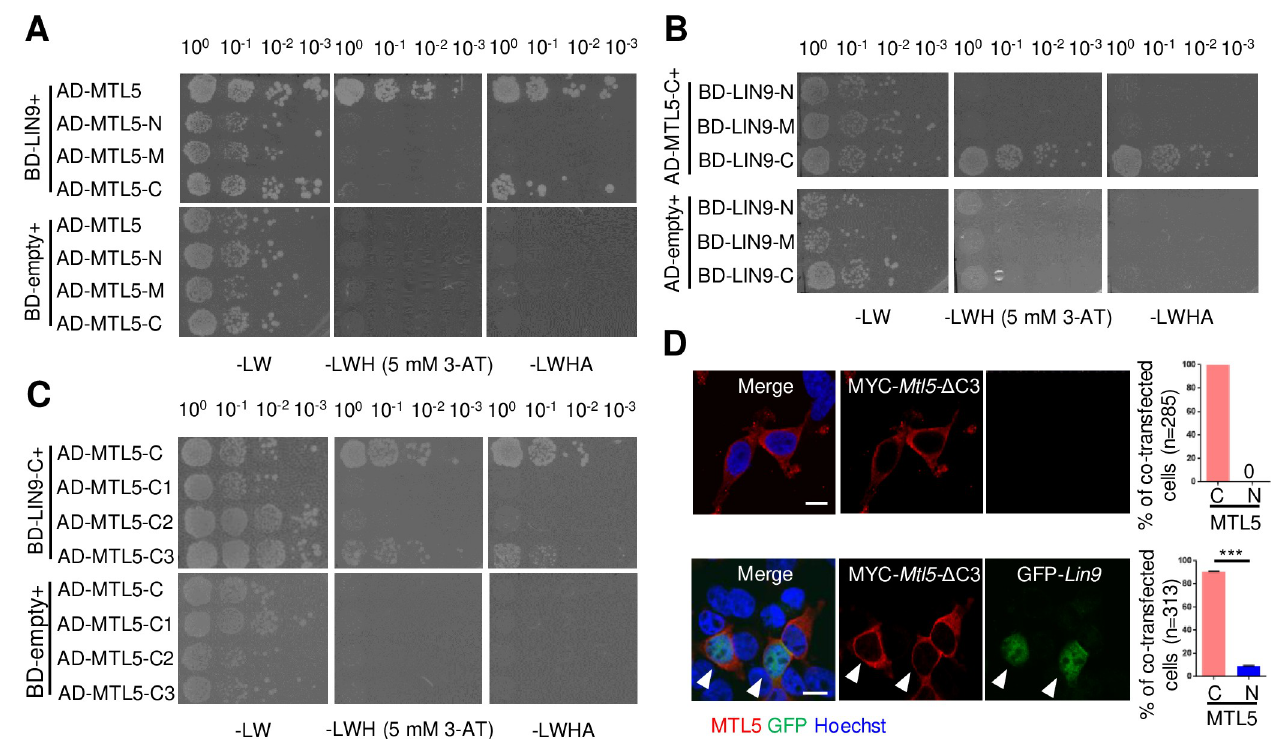
Fig 4. LIN9 directly interacts with MTL5 C-terminal residues 443–475 for transport of MTL5 into the nucleus. (A) The Y2H was used to assess the interaction of truncated MTL5 (MTL5-N, MTL5-M, and MTL5-C) with full length LIN9, respectively. MTL5-N contains residues 1–250 aa;MTL5-M contains residues 251–370 aa;MTL5-C indicates contains 371–475 aa. (B) Y2H assessment of interactions between of truncated LIN9 (LIN9-N, LIN9-M, and LIN9-C) with AD-MTL5-C (371–475 aa) respectively. LIN9-N contains residues 1–150 aa;LIN9-M contains residues 151–340 aa;LIN9-C contains residues 341–559 aa. (C) The interactions of AD-MTL5-C1 (371–418 aa), AD-MTL5-C2 (419–442 aa), and AD-MTL5-C3 (443–475 aa) with BD-LIN9-C (341–559 aa) or BD-empty (control) was assessed by Y2H, respectively. The interaction in (A-C) was tested by growth of the yeast cells on double (SD-Leu/Trp, -LW), triple (SD-His/Leu/Trp with 5 mM 3-AT, -LWH) or quadruple dropout medium plates (SD-Ade/His/Leu/Trp, -LWHA) at different dilutions. (D) HEK293T cells were transiently co-transfected with plasmids encoding MYC- Mtl5 - Δ C3 (C-terminal 443–475 aa residues were deleted) and GFP-LIN9. The localization of LIN9 and mutant MTL5 was detected by immunostaining with antibodies against GFP (green) and MTL5 (red), respectively. The nuclei (blue) of HEK293T cells were counterstained with Hoechst 33342. The cells with nuclear (N) or cytoplasmic (C) localization of MTL5 were counted and “n” in the brackets represent the number of (co-)transfected cells analyzed. White arrowheads indicates the localization of truncated MTL5 and LIN9 in HEK293T cells. Data are presented as mean ± SEM of three independent replicates. P values were detected by Student’s t -test. ��� p < 0.001. Scale bar, 10 μ